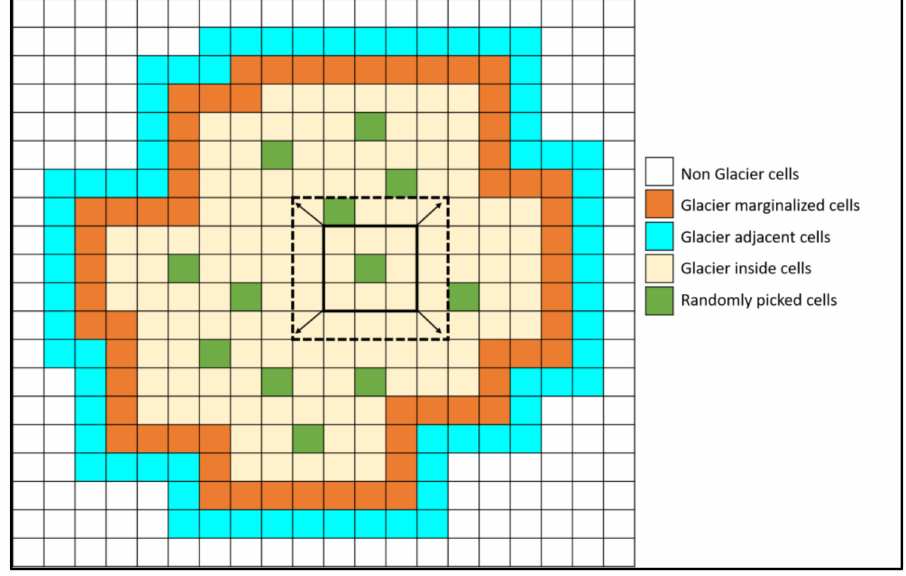
Figure 5. Schematic representation of the working principle of the GlabTop-2 model. Glacier polygons are transformed into a raster matching the DEM